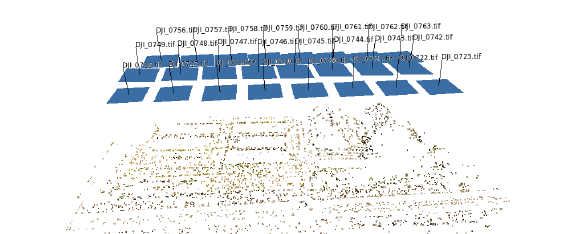
Figure 3. Ground truth camera poses and 3D points of the F IELD dataset.